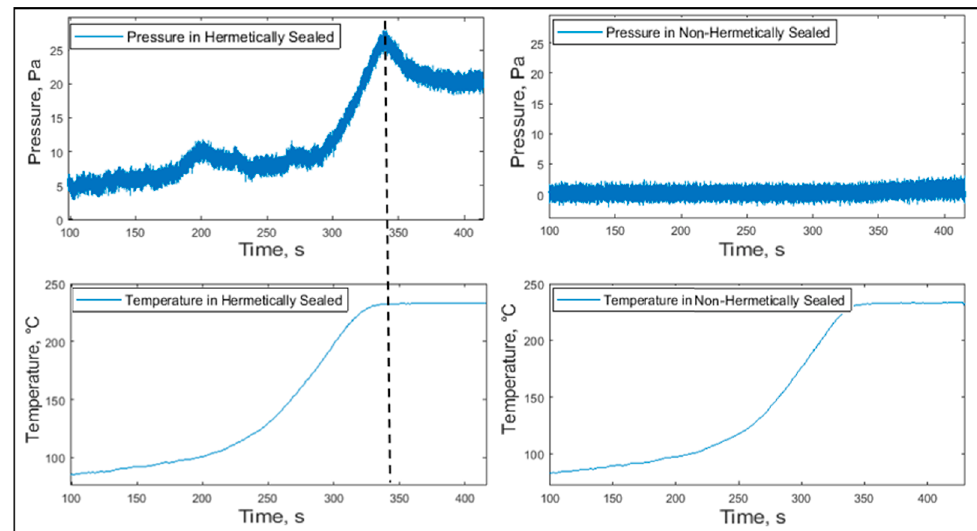
Figure 11. The profiles of the pressure and temperature in a hermetically and non-hermetically sealed oven.